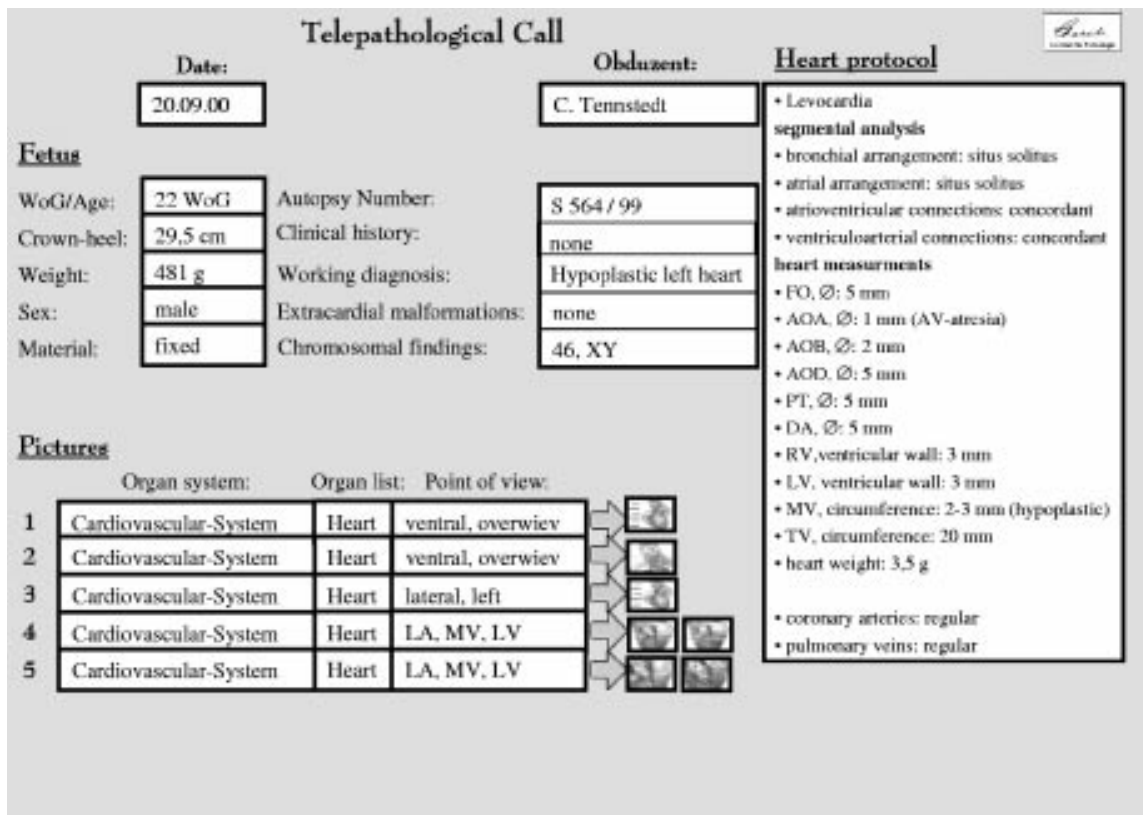
Fig. 1. The fetal autopsy laboratory with the technical equipment.